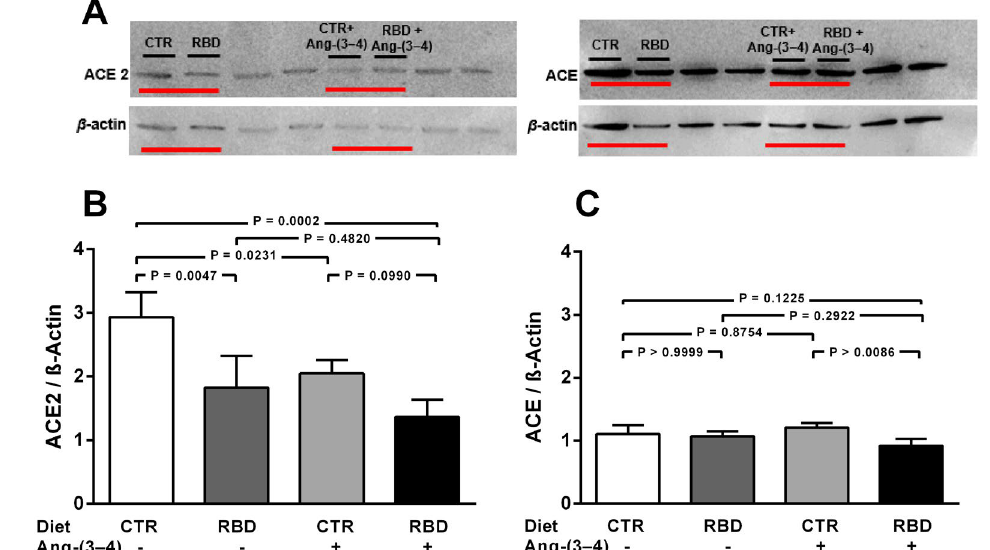
Figure 3. Chronic undernutrition downregulates ACE2, but not ACE, levels in juvenile rats. Effects of Ang-(3-4). A. Representative immunoblottings from renal cortex corticis of juvenile rats; β-actin was used as loading control; B and C. bargraph representation of ACE2 and ACE levels in renal cortex corticis . Bars indicate mean ± SEM ( N = 4 different membrane preparations). Combinations of diets and Ang-(3-4) administration as indicated above the representative immunodetections and on the abscissae. Statistical differences were estimated using one-way ANOVA followed by Bonferroni’s test for the selected pairs indicated within the panels. Significant differences were set at P < 0.05. In A, horizontal red lines under bands indicate, in uncropped immunoblottings, the representative immunodetections relative to the present study. The bands not underlined are not related to the work described in this report. Loading controls were run on the same blot as the representative ACE2 and ACE